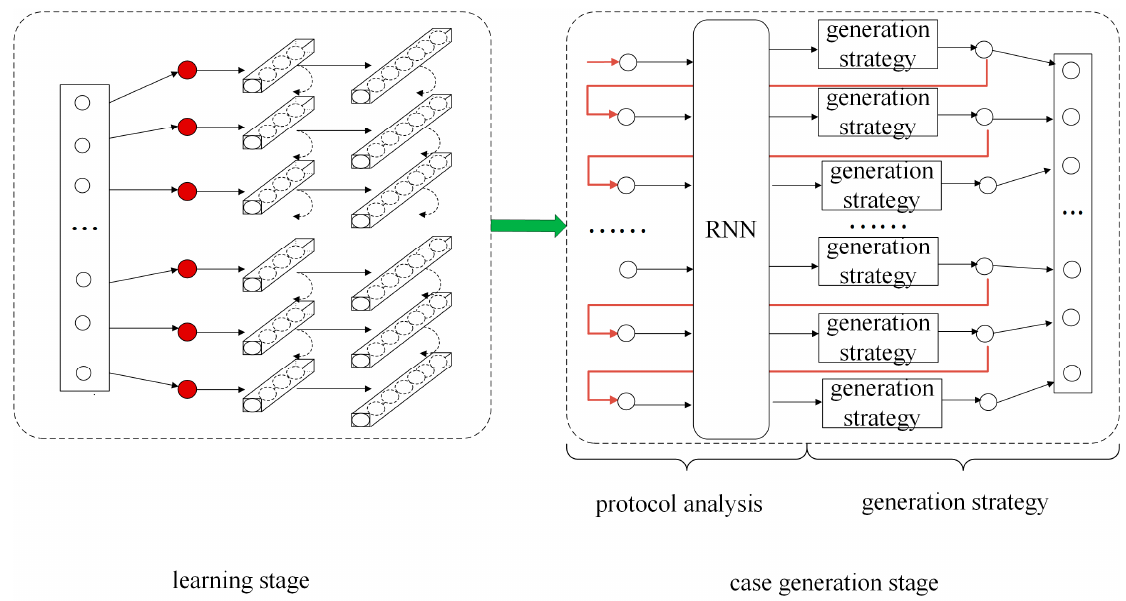
Figure 5. Generation model structure diagram of the industrial control network protocol.